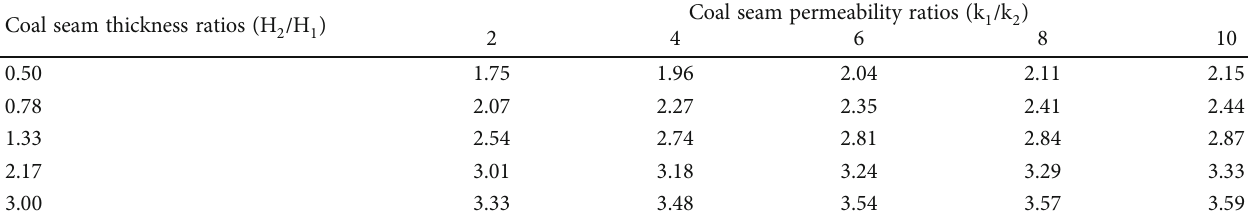
Table 5: Optimal VSAB for di ff erent coal seam permeability ratios and coal seam thickness ratios. Coal seam thickness ratios ( H 2 /H 1 )